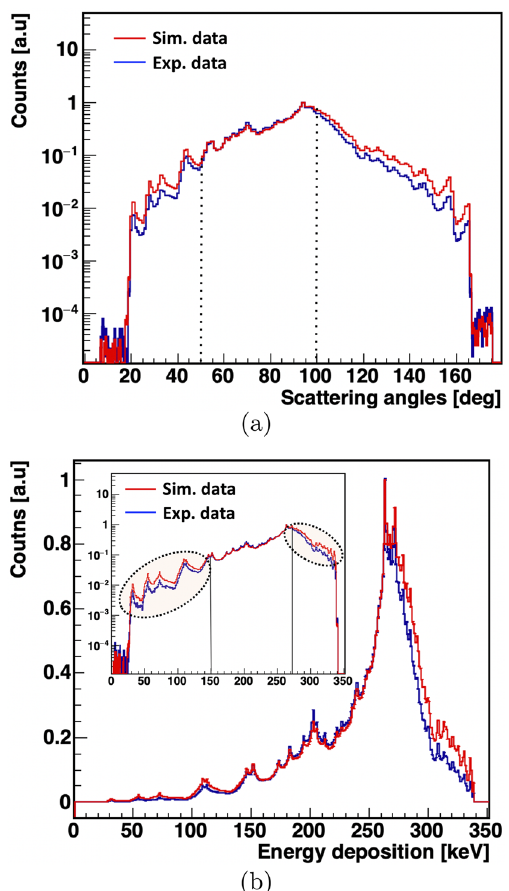
photons. Results of the experiment and simulations are shown in blue and red, respectively. In the inset, energy deposition spectra are shown in a logarithmic